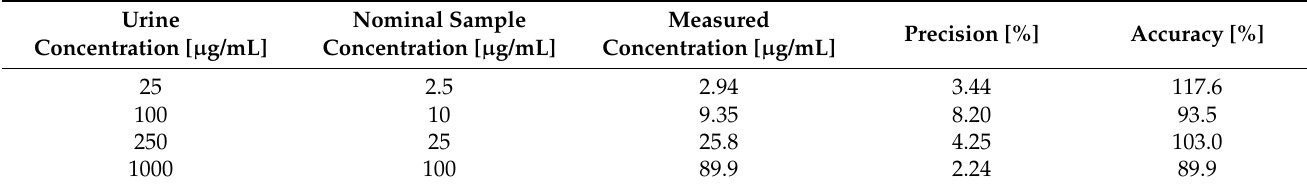
Table 2. Intra-day precision and accuracy of lysozyme measurement in human urine using the Lys-PMNPs ( n = 5). Urine